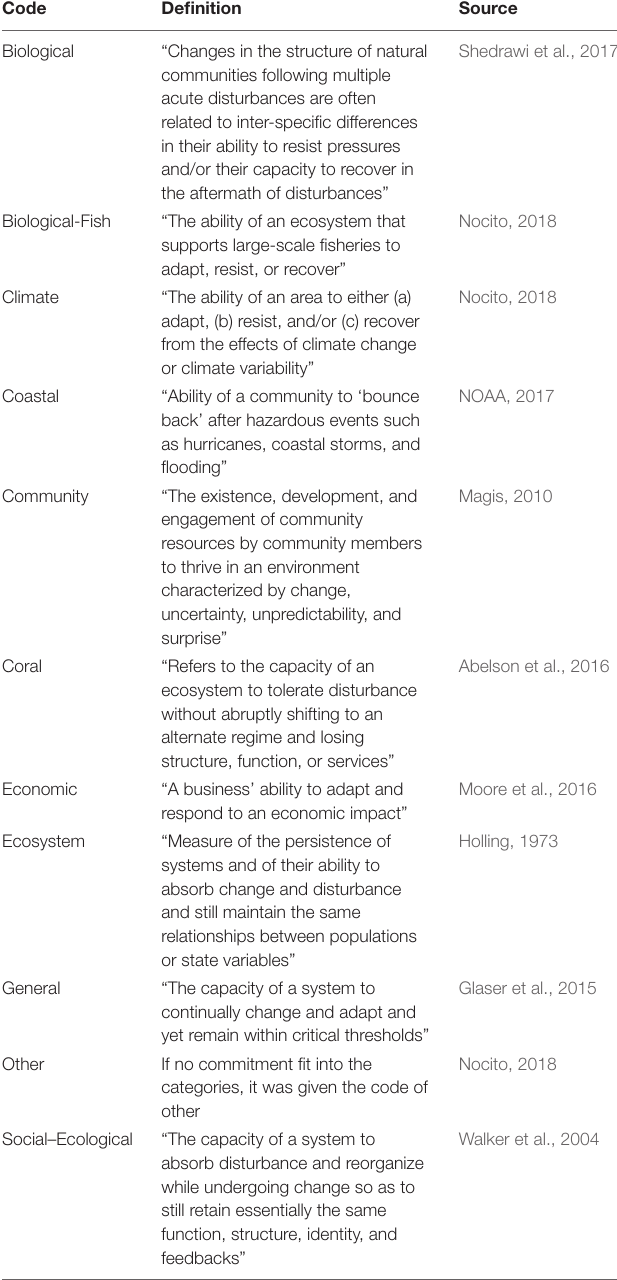
TABLE 2 | Definitions of different forms of